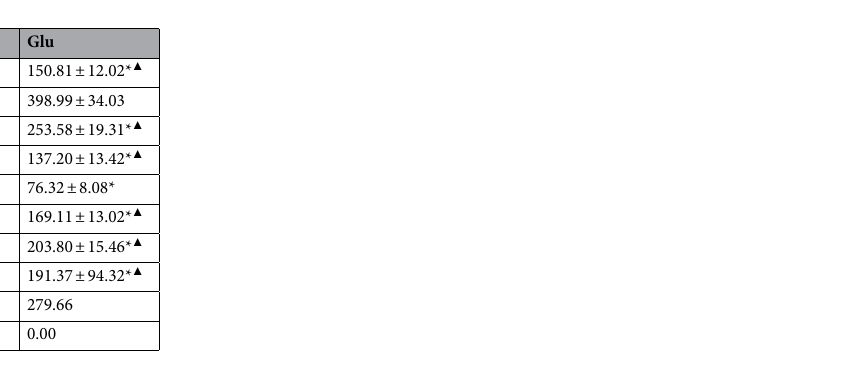
Table 1. Changes in Glu content (μmol/L) in brain extracellular fluid (± s n = 9). *Compared with ischemia for 10 min, *P < 0.05. ▲ Compared with rewarmed 60 min, ▲ P <